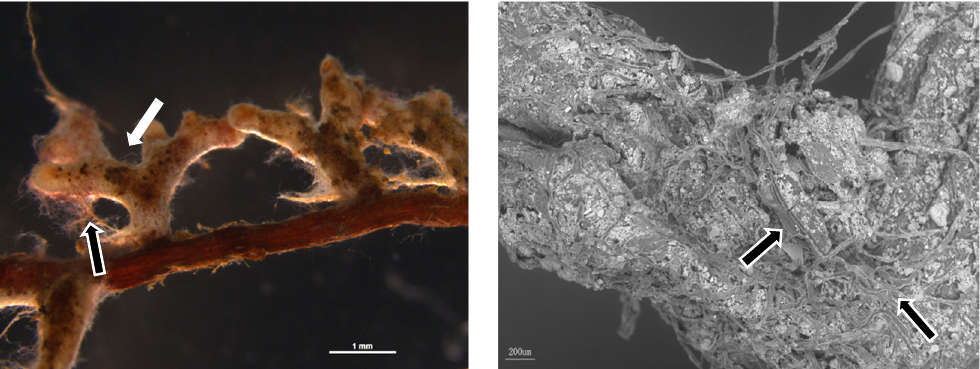
Figure 1. Colonization of Suillus luteus ( Sl ) on the root of Pinus massoniana . Dichotomous branches (white arrow), extraradical mycelium (black arrow).